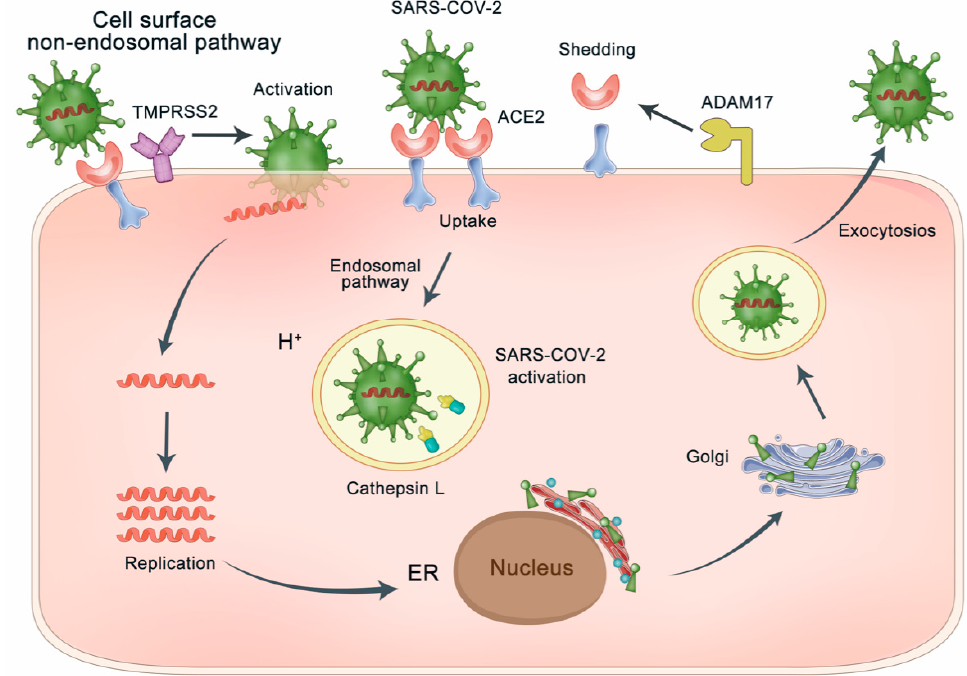
Figure 3. SARS-CoV-2 enters the host cell using the endosomal pathway and/or the cell surface non-endosomal pathway. The endosomal pathway is through ACE2–spike protein interaction, which triggers endocytosis of virus particles through internalization with the ACE2, further mediating the fusion of virus and host cells. In addition, the cell surface non-endosomal pathway for SARS-CoV-2 spike protein priming by TMPRSS2 for viral entry into the cell. ADAM-17 mediated shedding of ACE2 at the cell surface is an important pathological outcome of SARS-CoV-2 infection. TMPRSS2 competes with the metalloprotease ADAM-17 for ACE2 ectodomain shedding. Cleavage of ACE2 by TMPRSS2 enhances the S-protein-driven viral entry.